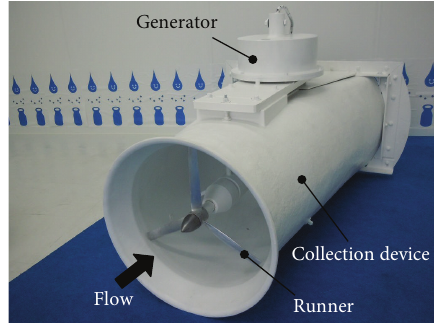
Figure 21: Prototype.